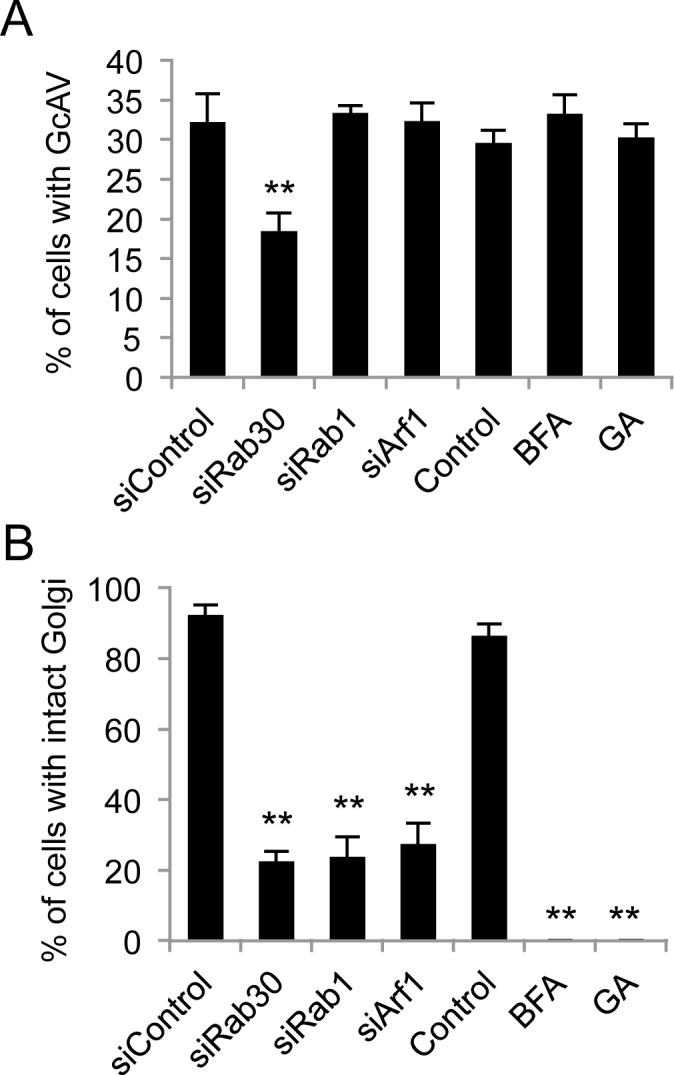
Involvement of Rab30 in GAS-induced autophagy is independent of its role in maintaining the structural integrity of the Golgi apparatus.(A) HeLa cells were transfected with EmGFP-LC3 and siRNAs against the indicated target mRNAs, or were treated with BFA or GA, as indicated. Subsequently, the cells were infected with GAS (MOI = 100). The cells were then fixed, permeabilized, and stained with DAPI. The percentage of cells with GcAVs was quantified. (B) HeLa cells were transfected with siRNAs against indicated target mRNAs, or treated with BFA or GA, after which they were infected with GAS. Cells were fixed, permeabilized, and immunostained with an anti-GM130 antibody. The percentage of cells with intact Golgi structure was quantified. The data shown represent the results of >200 cells in terms of the mean value ± SD from 3 independent experiments. ** P < 0.01.